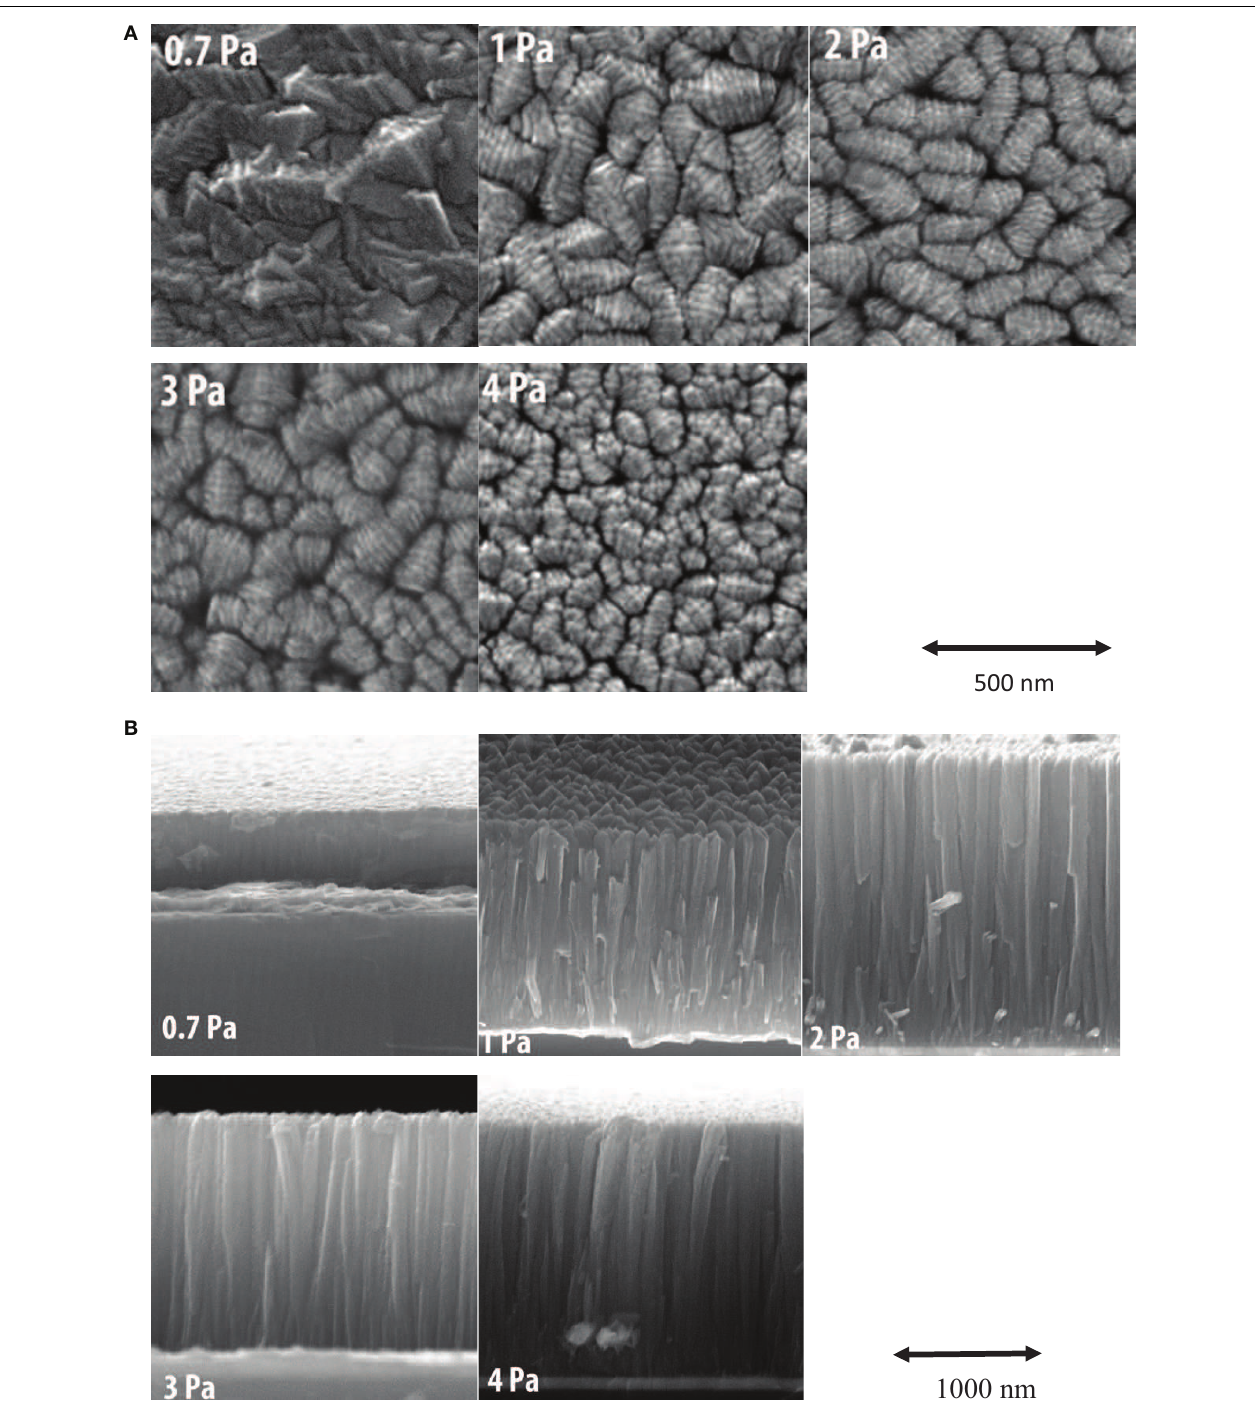
FIGURE 2 | (A) The surface SEM images ofTiO 2 samples prepared at different sputtering pressures. (B) The cross-sectional SEM images ofTiO 2 samples prepared at different sputtering pressures.